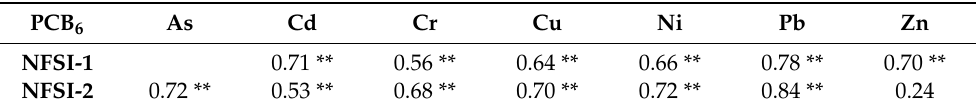
Table 4. Correlation coefficients between PCB 6 concentration and the As, Cd, Cr, Cu, Ni, Pb and Zn concentrations in the humus layer of Brandenburg NFSI sites, differentiated for data from NFSI-1